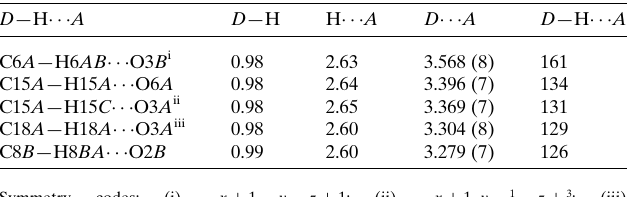
Table 2 Hydrogen-bond geometry (A˚ , (cid:2) ).